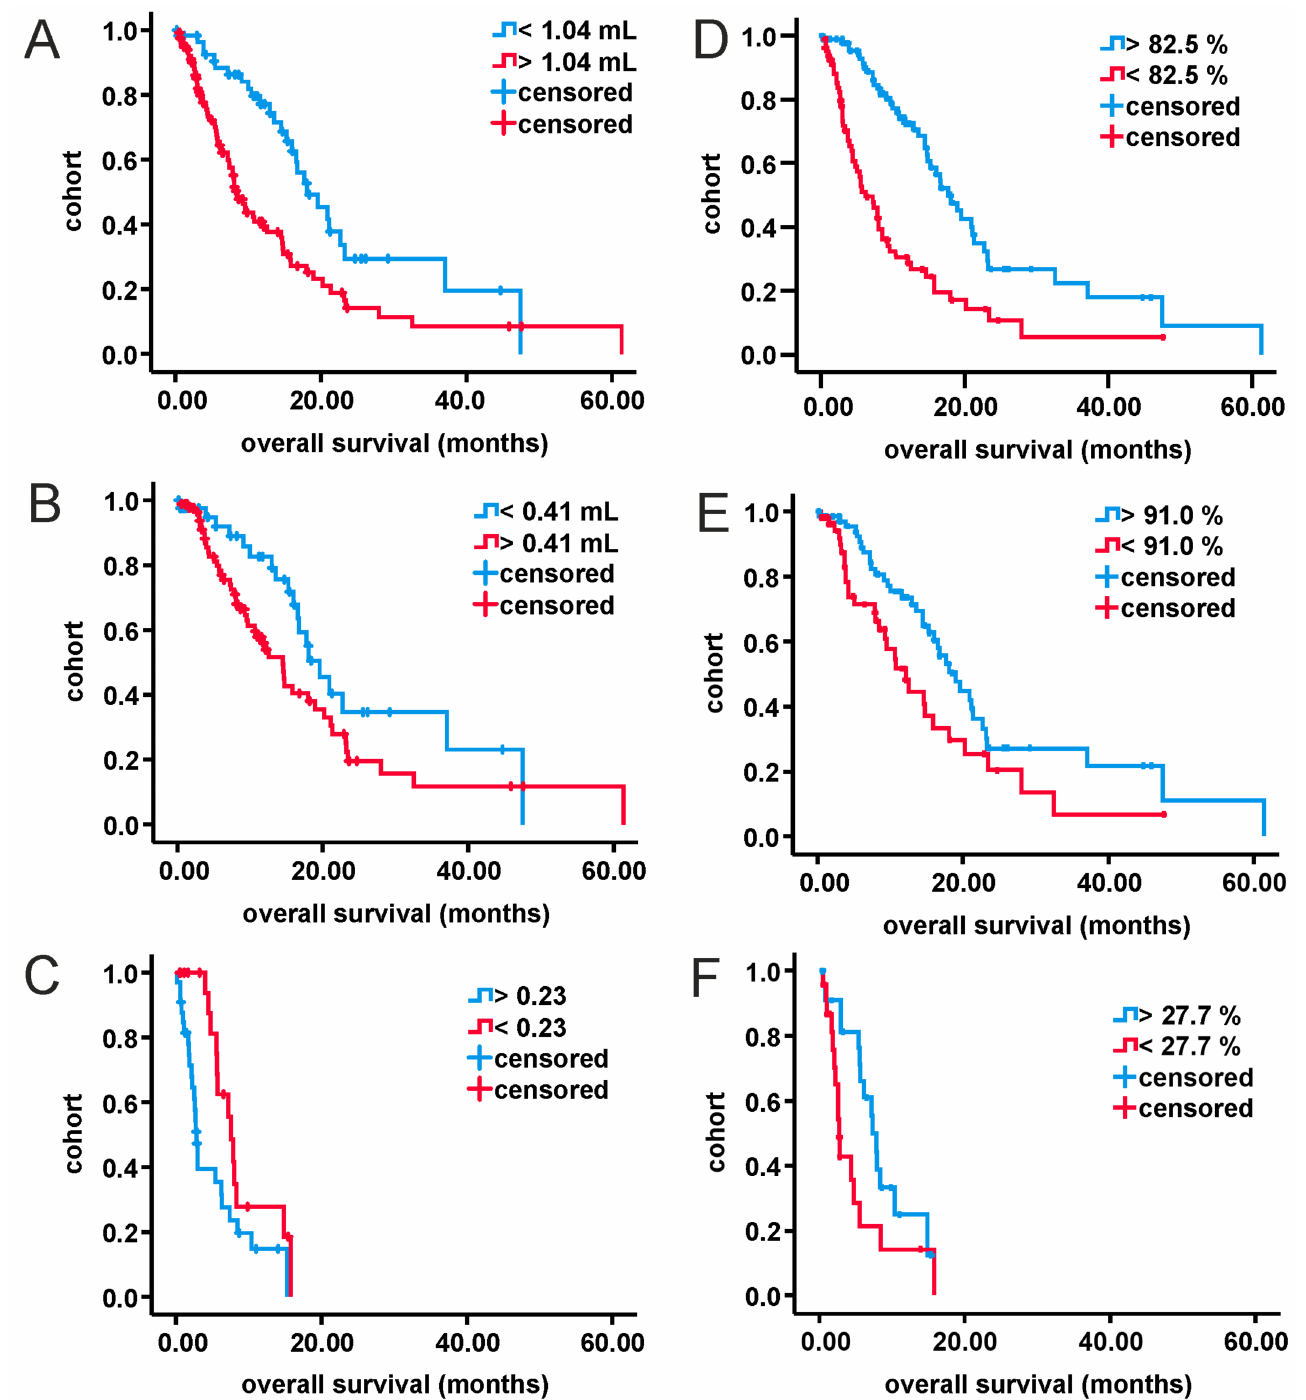
Figure 3. Kaplan–Meier analysis of categorized volumetric parameters for all three study cohorts. ( A ): entire cohort, residual tumor volume; ( B ): uGBM, residual tumor volume; ( C ): mGBM, ratio of tumor necrosis volume to initial tumor volume; ( D ): entire cohort, extent of resection; ( E ): uGBM, extent of resection; ( F ): mGBM, extent of resection. mGBM: multifocal glioblastoma; uGBM: unifocal